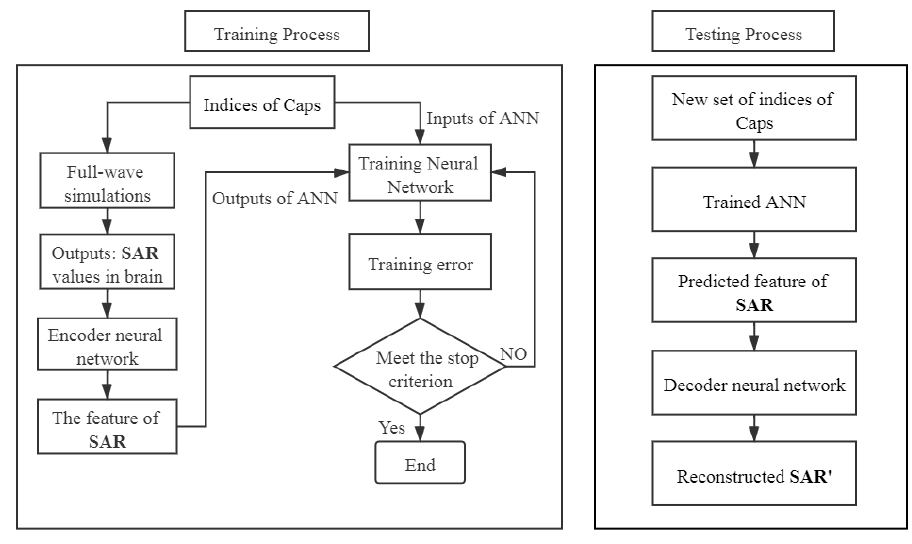
Figure 4. Structure of the proposed surrogate model for uncertainty quantification